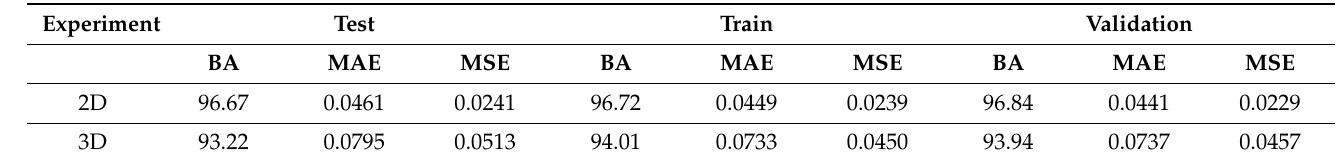
Table 4. Results of the Res-U-Net on the Dataset#3.